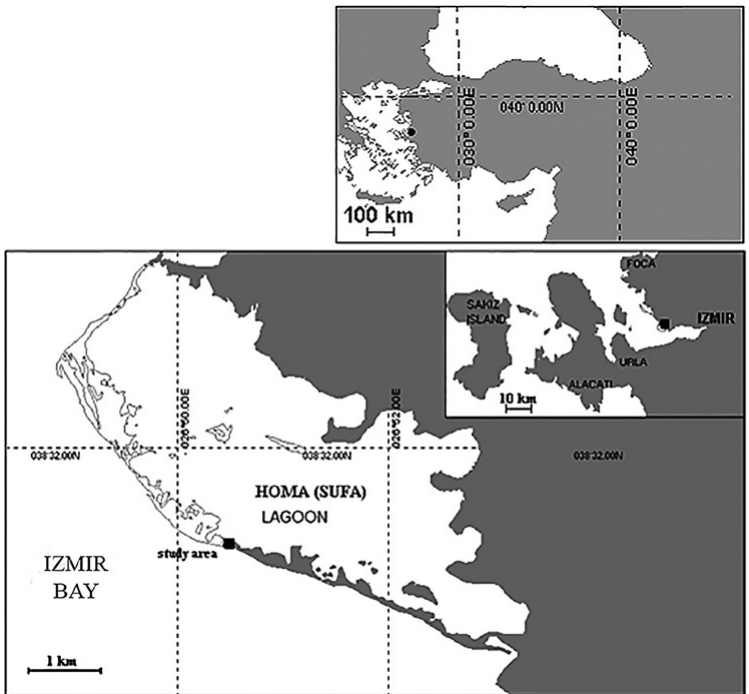
Fig. 1. – Location of the study area (full square) in Homa Lagoon, Izmir Bay,